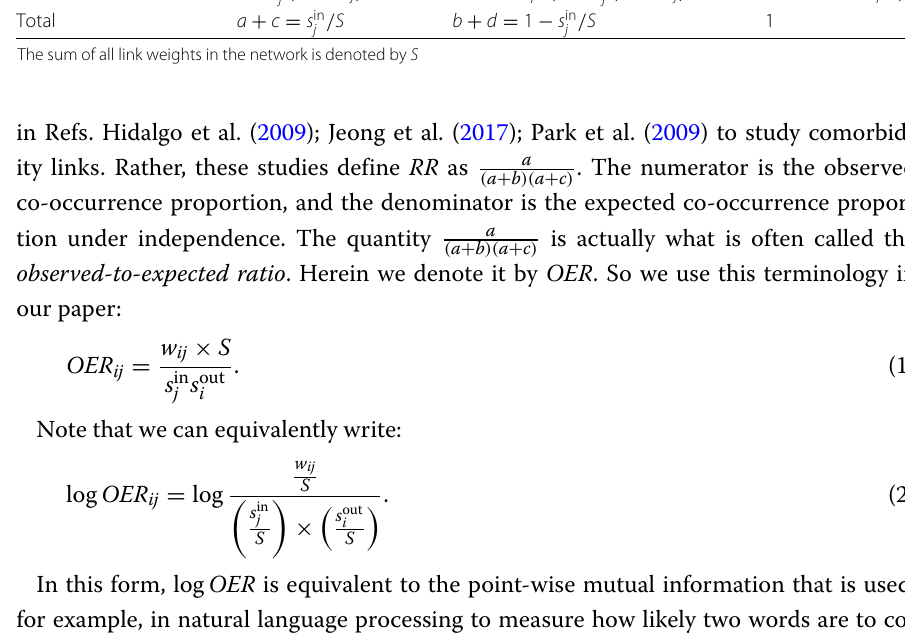
Table 2 The contingency table to analyze the comorbidity of diseases i and j Second disease is j Second disease is not j Total First disease is i a = w ij / S b = s out i / S − w ij / S a + b = s out i / S First disease is not i c = s in j / S − w ij / S Total a + c = s in j / S